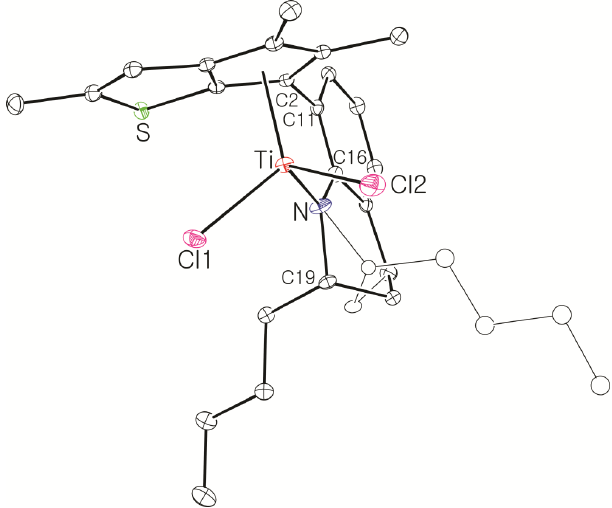
Figure 2. Thermal ellipsoid plot (30% probability level) of 15 . Hydrogen atoms are omitted for clarity.